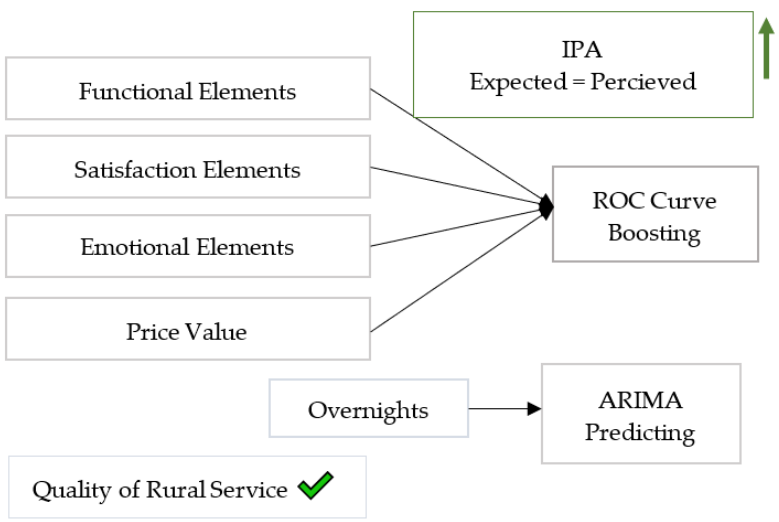
Figure 1. Conceptual framework.